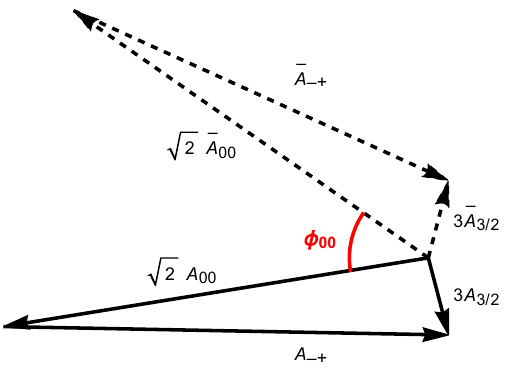
Fig. 5 Illustrationoftheamplitudetrianglesfollowingfromtheisospin relations in Eqs. (111) and (112). The solid triangle corresponds to the → π 0 K 0 , B 0 → π − K + decays while the dashed one B 0 d d